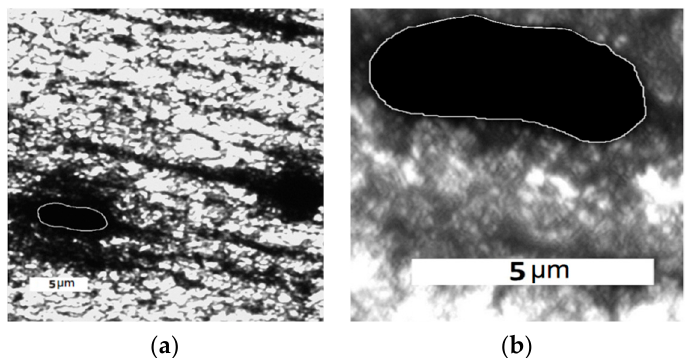
Figure 1. Images the sample surface after SACP at τ c = 10 min in 0.1 M NaCl solution. Magnification is ( a ) 5×; ( b ) 20×.